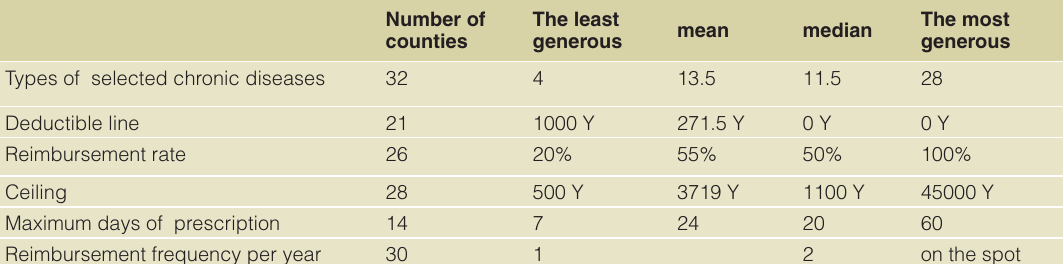
Table 3. Comparison of the generosity of cost-sharing within the 32 benefit packages for outpatient chronic disease treatments (Y = Yuan